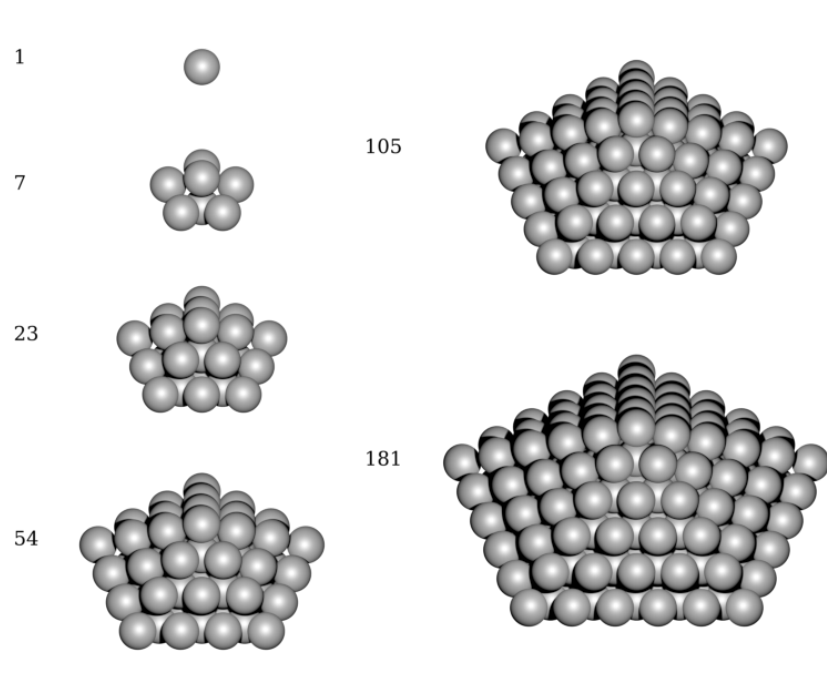
Figure 2. A schematic visualization of studied decahedron nanoclusters and nanoparticles (for higher number of atoms) with each of them accompanied by the number of